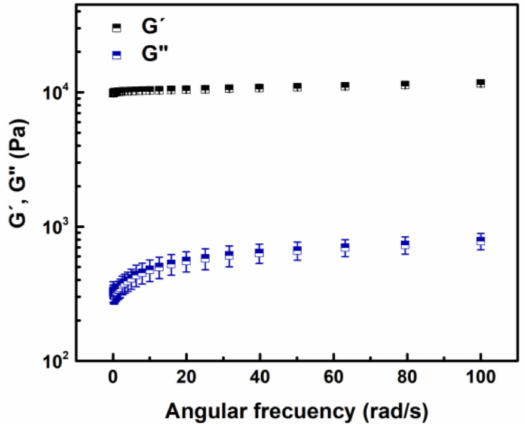
Figure 2. The relationship of storage ( G’ ) and loss ( G” ) modulus with angular frequency of oscillation for PVP hydrogel at 25 ◦ C. Results are expressed as the mean and standard deviation of the three independent measurements.